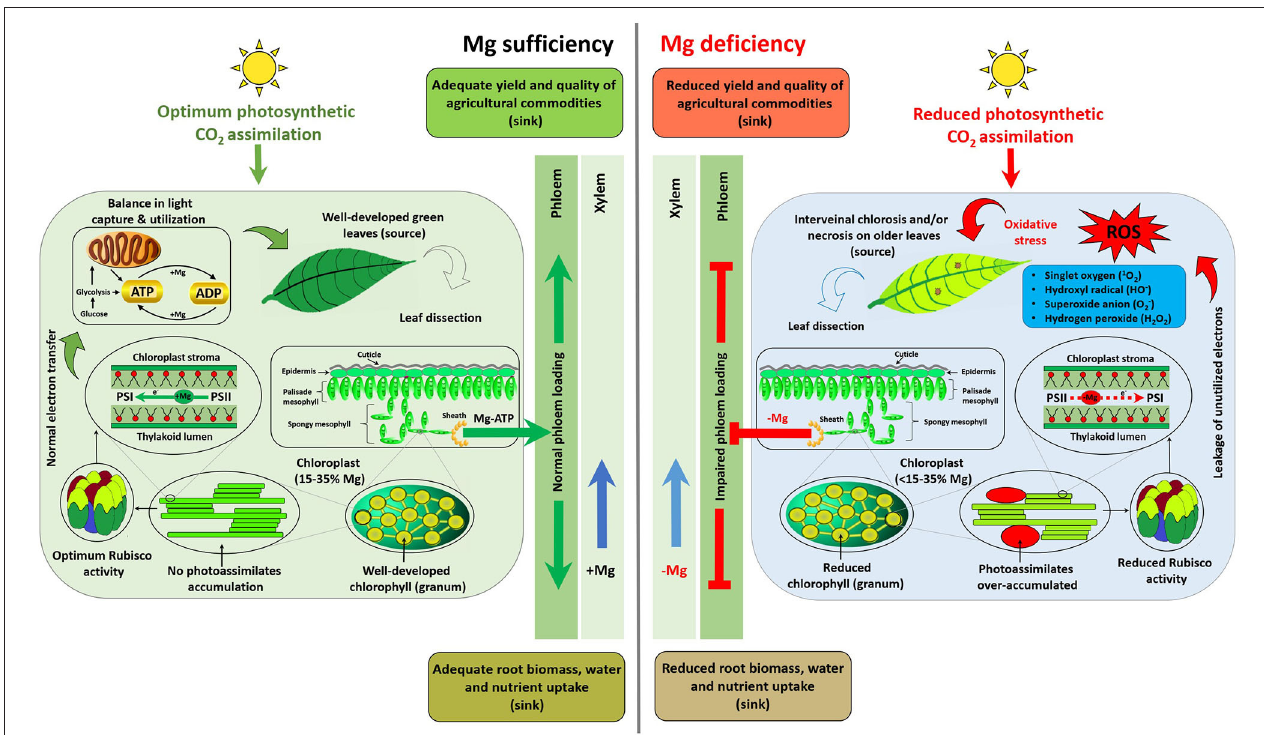
FIGURE 1 | Scheme depicting distinct responses of plants to Mg availability. Plant response to MGD can be summarized as (1) sub-optimal photosynthetic CO 2 assimilation; (2) impaired carbohydrate transportation from the source (fully expanded older leaves) to sinks (root, young growing points, or yield-forming organs); (3) photoassimilate (starch and sucrose) accumulation in source leaves; (4) reformed rounded and larger chloroplasts; (5) imbalanced light capture and utilization; (6) leakage of electrons from photosynthetic apparatus; (7) generation of reactive oxygen species (ROS); (8) oxidative stress; (9) degradation of chlorophyll (a & b) and reduced activities of Mg-depended enzymes, i.e., Rubisco; and (10) ultimately the appearance of interveinal chlorosis and/or necrotic spots on fully expanded (mature) leaves. Impaired phloem loading results in suppression of root growth, uptake of nutrients and water along with yield and quality traits of agricultural